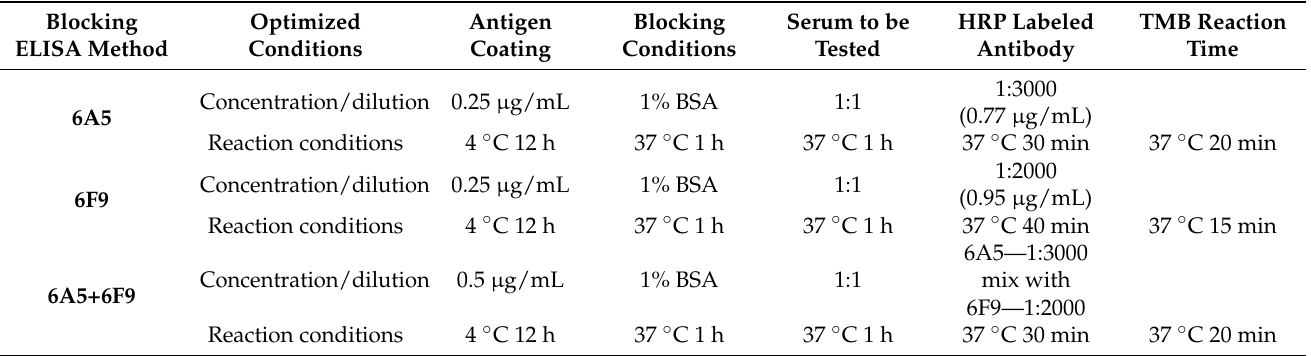
Table 1. The optimization of react condition of ASFV p54 protein blocking enzyme-linked immunosor- bent assay